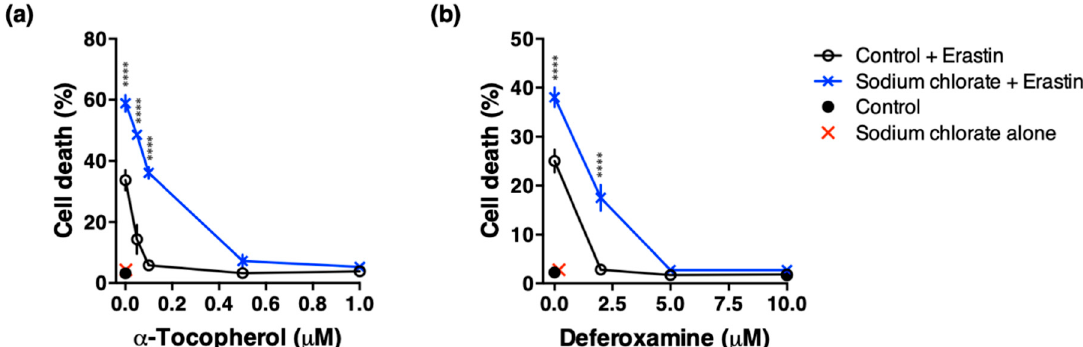
Figure 6. E ff ect of α -tocopherol or deferoxamine on erastin-induced cell death in the presence or absence of sodium chlorate. ( a ) ROS scavenging by α -tocopherol mitigated enhanced toxicity of sodium chlorate. ( b ) Iron chelating by deferoxamine mitigated enhanced toxicity of sodium chlorate. HT22 cells were treated with 0.2 µ M erastin and indicated concentrations of α -tocopherol or deferoxamine in the presence or absence of 60 mM sodium chlorate for 24 h and cell death was determined by LDH assay. The data are presented as the mean ± SD. The data were obtained from at least four independent cultures. **** p < 0.0001 compared with control + erastin at the same